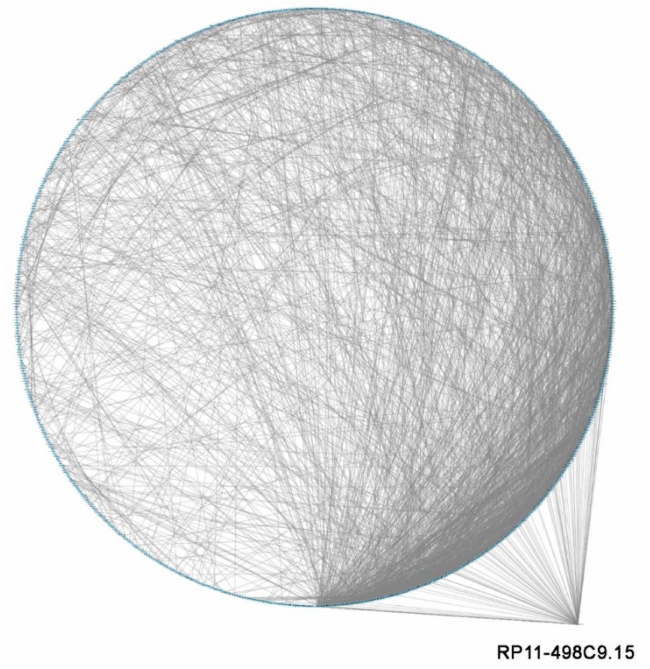
Figure 3. Graphical representation of connections among RP11-498C9.15 and modulated genes in the PPI network. Di ff erentially expressed genes in RA patients are ordered around a circle based on their degree of connectivity (number of